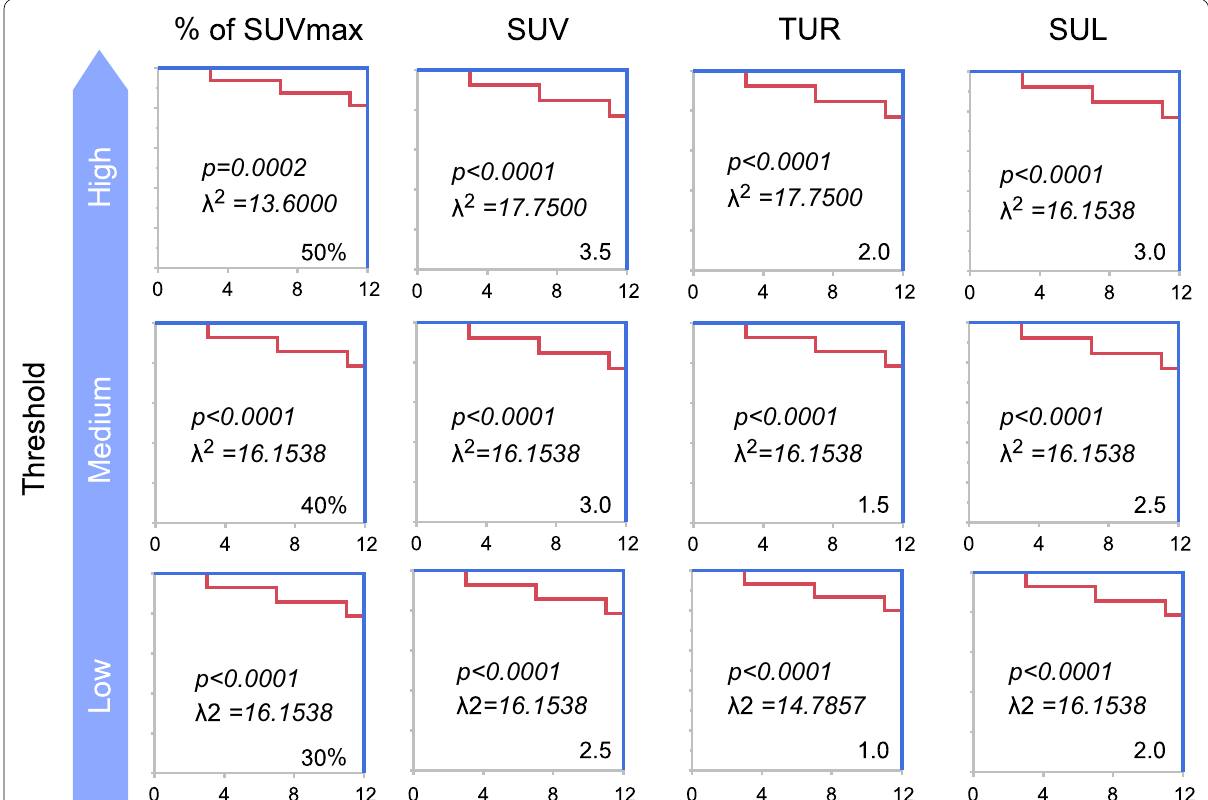
Fig. 3 Relapse-free survival curve showing MTV for each threshold. SUVmax, maximal standardized uptake value; MTV, metabolic tumor volume; TLG, total lesion glycolysis; TUR, tumor-to-liver uptake ratio; SUL, SUV normalized to lean body mass; ROC: receiver operating characteristic curve. Relapse-free survival curves of the patients were divided by values below and above the cut-off value obtained using ROC analysis. For all the parameters for MTV, particularly the SUVmax of 3.5 (MTV 3.5, and TLR of 2 (MTV-TLR2), the values above the cut-off value were more frequently associated with recurrence than the values below the cut-off